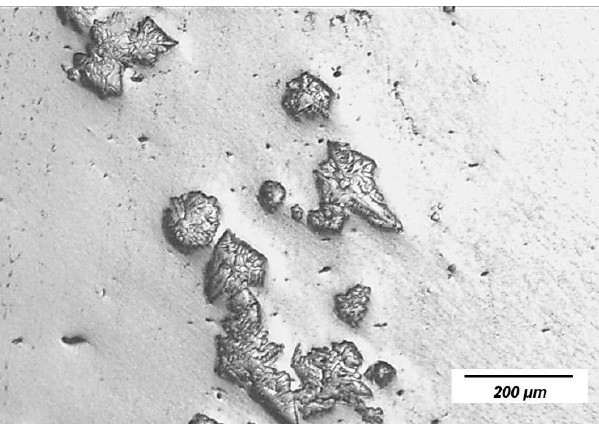
Figure 3. Optical image of crystals dispersed in glassy film (slag bulk temperature 1300 °C).